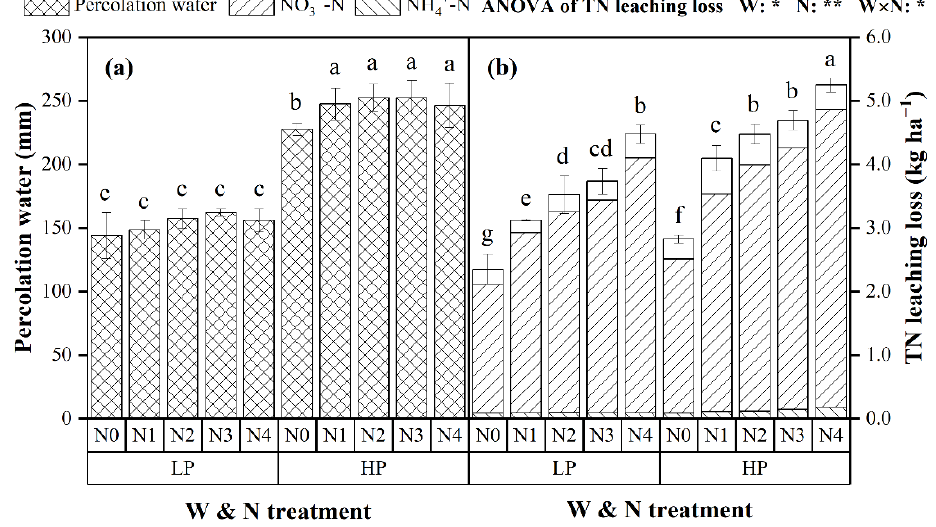
Figure 4. Percolation water ( a ) and total nitrogen (TN, ( b )) leaching loss under various water and N treatments. Different letters next to means denote significant differences based on Least Significant Difference test (LSD test, p < 0.05). * and ** denote significant at 0.05 and 0.01 levels, respectively, while ns is non-significant ( p > 0.05). LP and HP, i.e., low percolation and high percolation, represent two deep percolation rates controlled by the lysimeters, 3 mm d − 1 and 5 mm d − 1 , respectively. N0~N4 represent 0, 60, 135, 210 and 285 kg N ha − 1 application with straw returning, respectively.